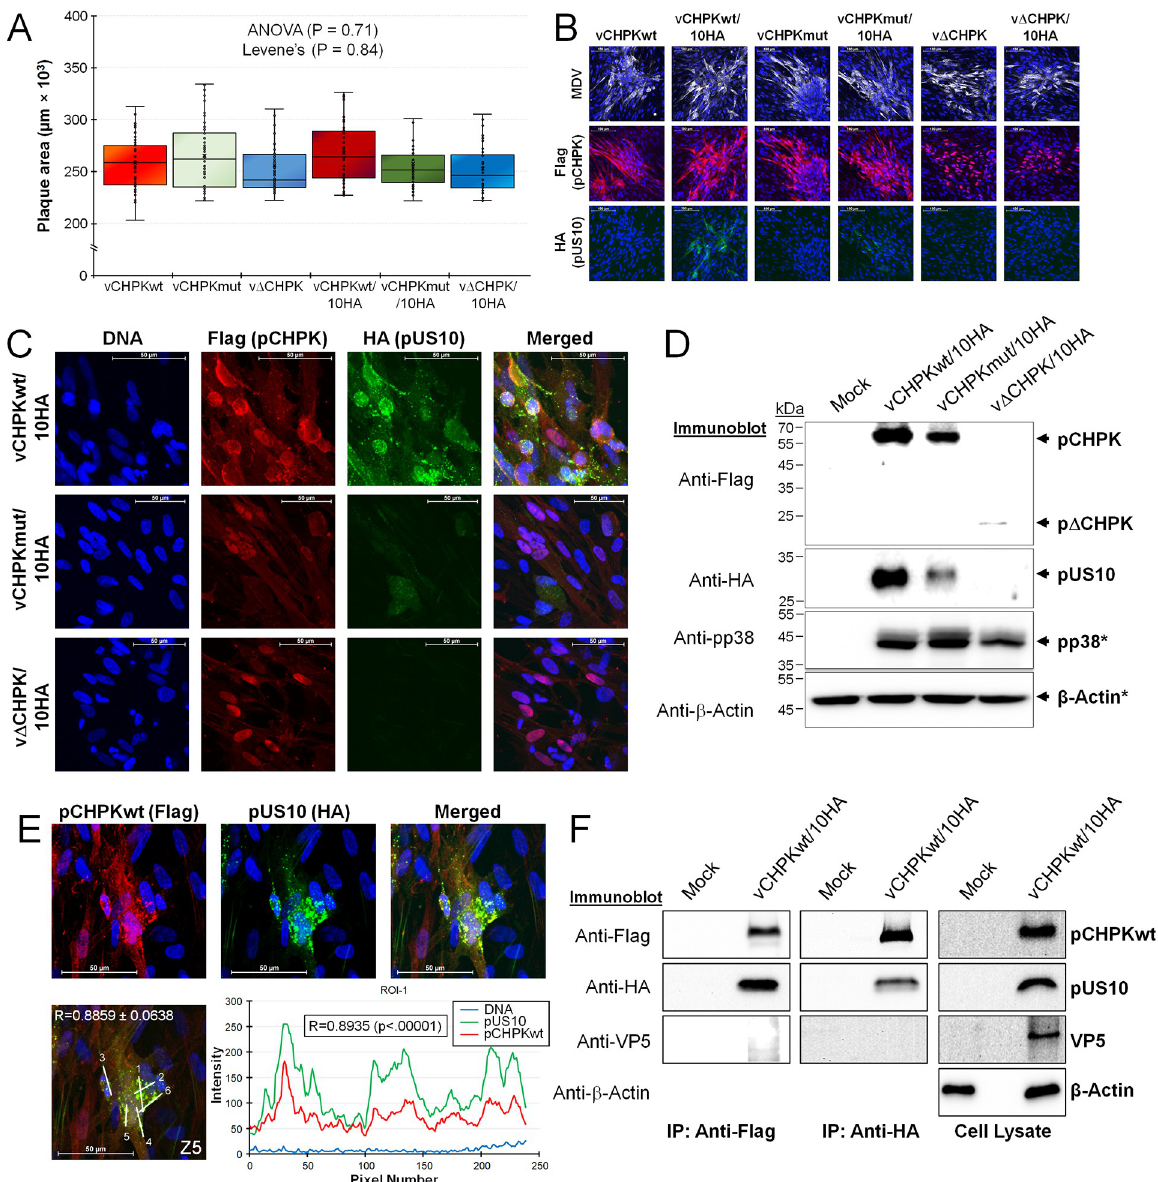
Fig 3. Replication of rMDVs in tissue culture cells and expression of pCHPK and pUS10. (A) Plaque areas were measured for rMDVs reconstituted from each parental virus (vCHPKwt, vCHPKmut, v Δ CHPK) and HA-tagged US10 virus (vCHPKwt/10HA, vCHPKmut/10HA, v Δ CHPK/10HA). There were no significant differences between all groups using One-way ANOVA ( P = 0.71, n = 300) and Levene’s Test ( P = 0.84, n = 300). (B) Representative plaques induced by each virus stained with anti-MDV, -Flag, and -HA antibodies. Included in each image is Hoechst 33342 staining of nuclei for reference. Scale bars are 100 μ m. (C) Confocal microscopy of vCHPKwt/10HA-, vCHPKmut/10HA-, or v Δ CHPK/10HA-infected CECs. Cells were stained for Flag (CHPK) and HA (US10), and DNA (Hoechst 33342). Scale bars are 50 μ m. (D) Immunoblotting of total protein collected from mock-infected CECs or CECs infected with vCHPKwt/10HA, vCHPKmut/10HA, or v Δ CHPK/ 10HA. To examine CHPK and US10 expression, proteins were electrophoresed under non-reducing conditions and blotted with anti-Flag (CHPK) and -HA (US10) antibodies. Protein was also run under reducing conditions ( � ) and blotted with anti- β -Actin and -MDV pp38 as protein loading and infection level controls, respectively. (E) Confocal images of CECs infected with vCHPKwt/10HA were used to quantify the colocalization of pCHPK and pUS10. A representative image of a plaque stained with anti-Flag (pCHPKwt) and -HA (pUS10) and merged. Hoechst was used to identify cell nuclei. Scale bars are 50 μ m. A single z-section with linear ROIs labeled and the profile plot for ROI-1, and its Pearson Correlation Coefficient R is shown. The average Pearson Correlation Coefficient R between pCHPKwt and pUS10 was 0.8859 ± 0.0638. (F) Uninfected CECs (Mock) or CECs infected with vCHPKwt/10HA were used for protein extraction and total cell lysate was immunoblotted for pCHPKwt (Flag), pUS10 (HA), VP5 (non-specific control), and β -Actin (protein loading control). Total lysate was immunoprecipitated with anti-Flag Fab or anti-HA combined with protein A/G-beads, electrophoresed on an SDS-PAGE gel, and then immunoblotted using anti-Flag, -HA, or VP5